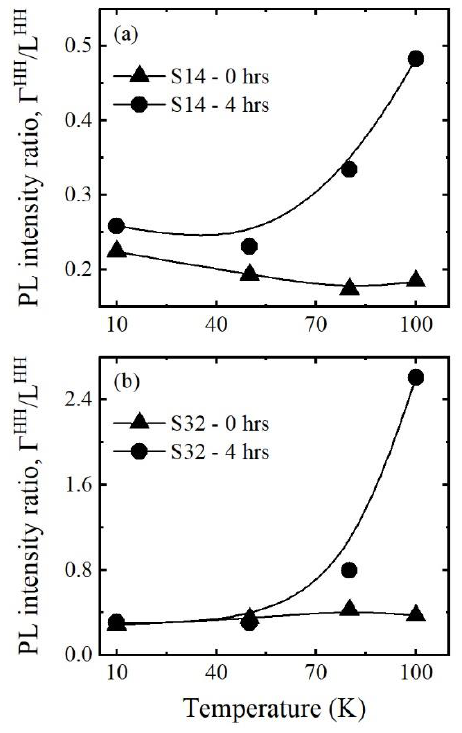
Figure 8. Temperature dependent PL intensity ratio Г HH /L HH . ( a ) S14; ( b )